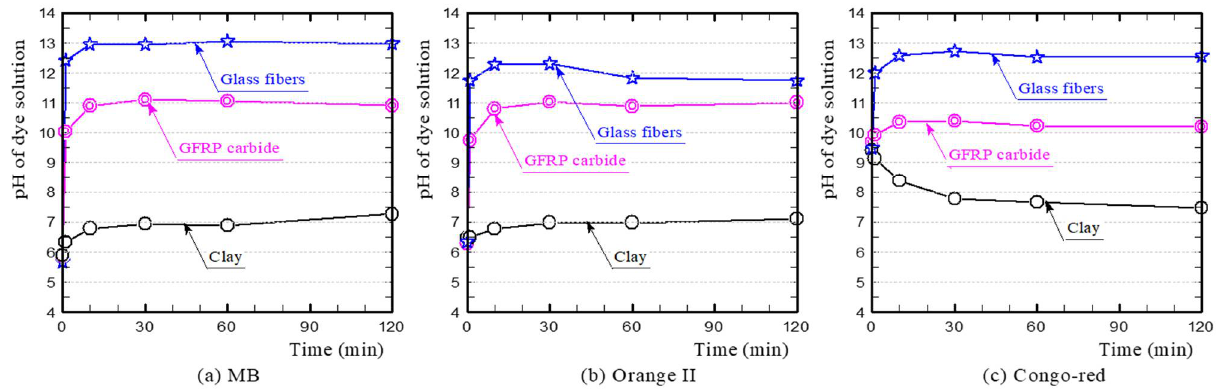
Figure 10. Temporal changes in pH of MB ( a ), Orange II ( b ) and Congo-red ( c ) dye solutions. (a) MB